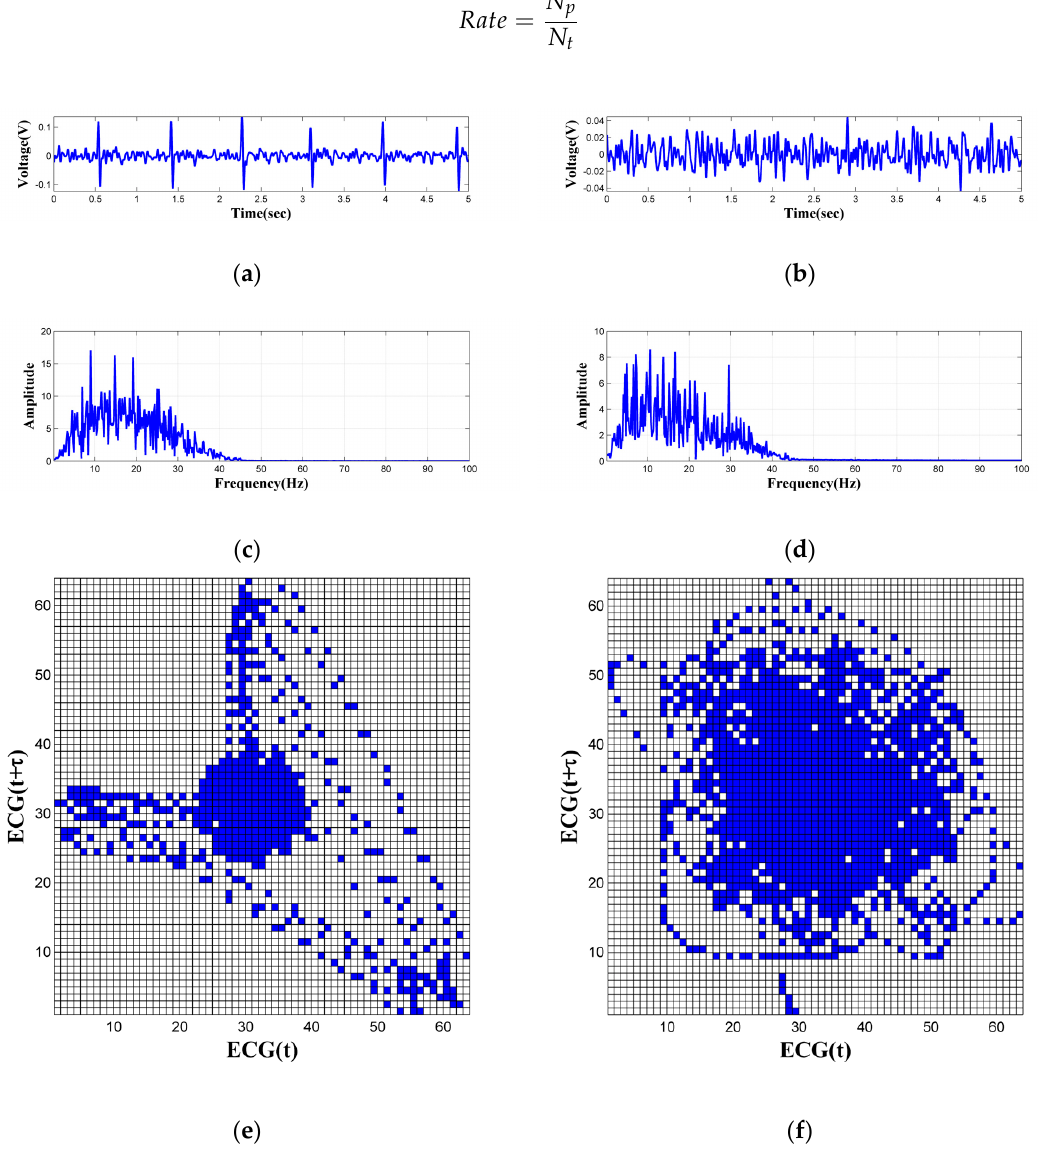
Figure 6. The frequency domain features of ECG signals and phase portraits boxes visualized: ( a ) The clear ECG signals; ( b ) The noisy ECG signals; ( c ) The frequency domain features of the clear ECG signals; ( d ) The frequency domain features of the noisy ECG signals; ( e ) The gridded phase portraits of the clear ECG signals; ( f ) The gridded phase portraits of the noisy ECG signals.